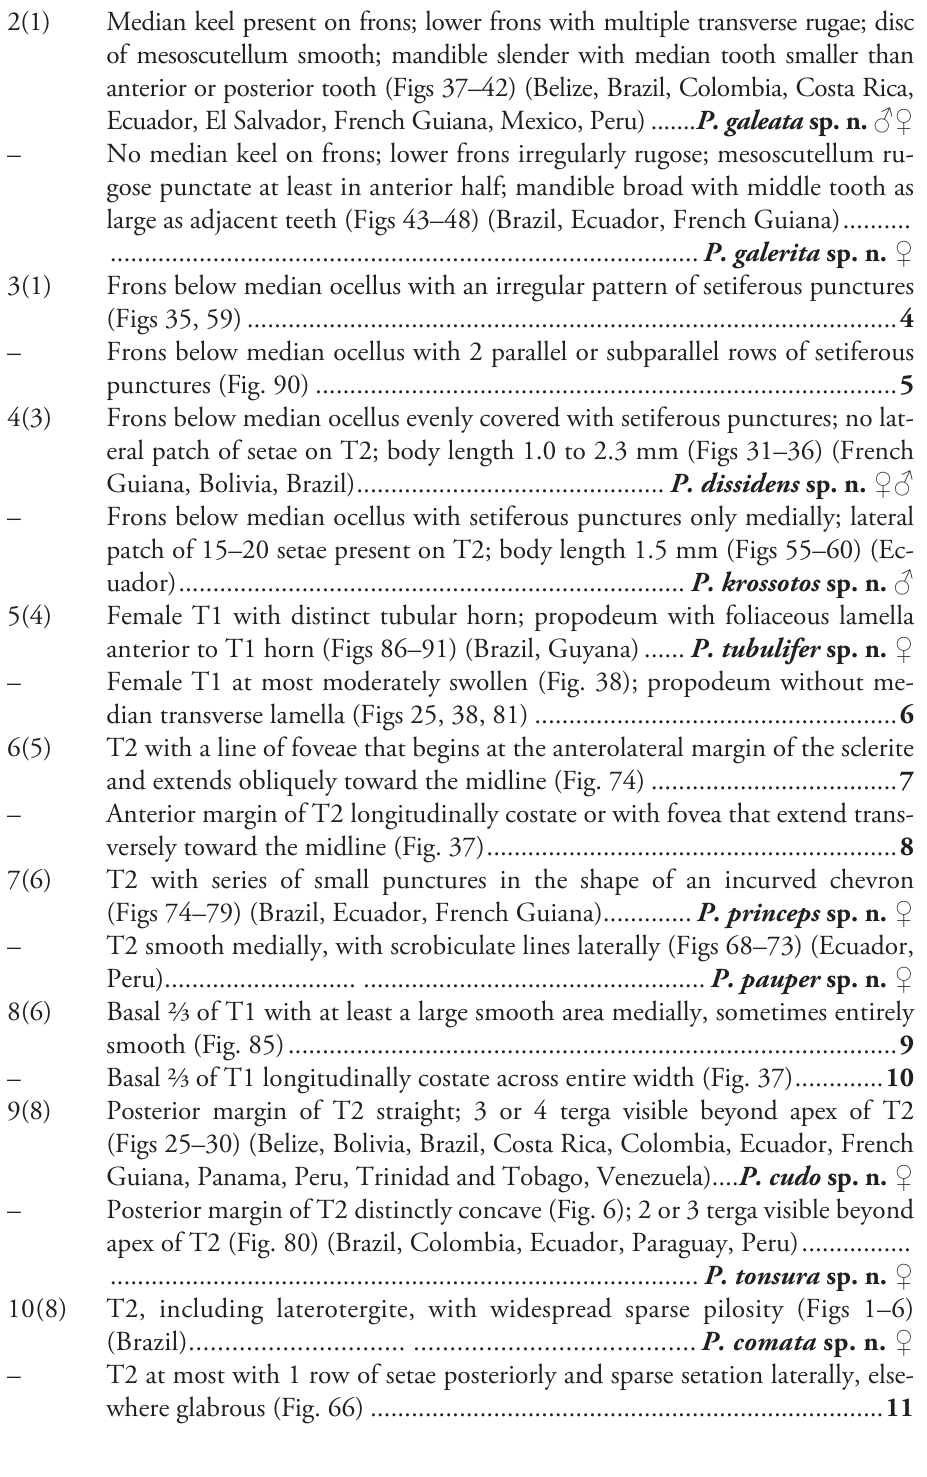
Median keel present on frons; lower frons with multiple transverse rugae; disc of mesoscutellum smooth; mandible slender with median tooth smaller than anterior or posterior tooth (Figs 37–42) (Belize, Brazil, Colombia, Costa Rica, Ecuador, El Salvador, French Guiana, Mexico, Peru) ....... P. galeata sp. n.